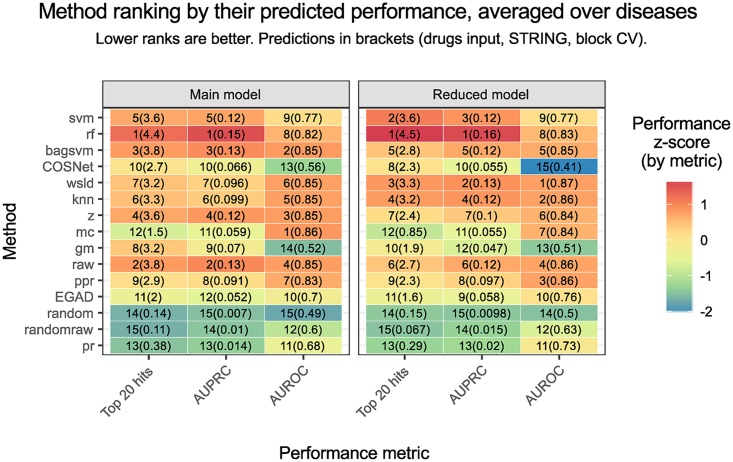
Ranking of all the methods.Ranking according to the predictions of the main explanatory models (left) and the reduced explanatory models within the STRING network and block cross-validation (right), in both cases on the drugs input and averaging over diseases. The main models serve as a global description of the metrics, whereas the reduced models are specific to the scenario of most interest. A column-wise z-score on the predicted mean is depicted, in order to illustrate the magnitude of the difference. Note how the top 20 hits and the AUPRC metrics lead to similar conclusions, as opposed to AUROC.